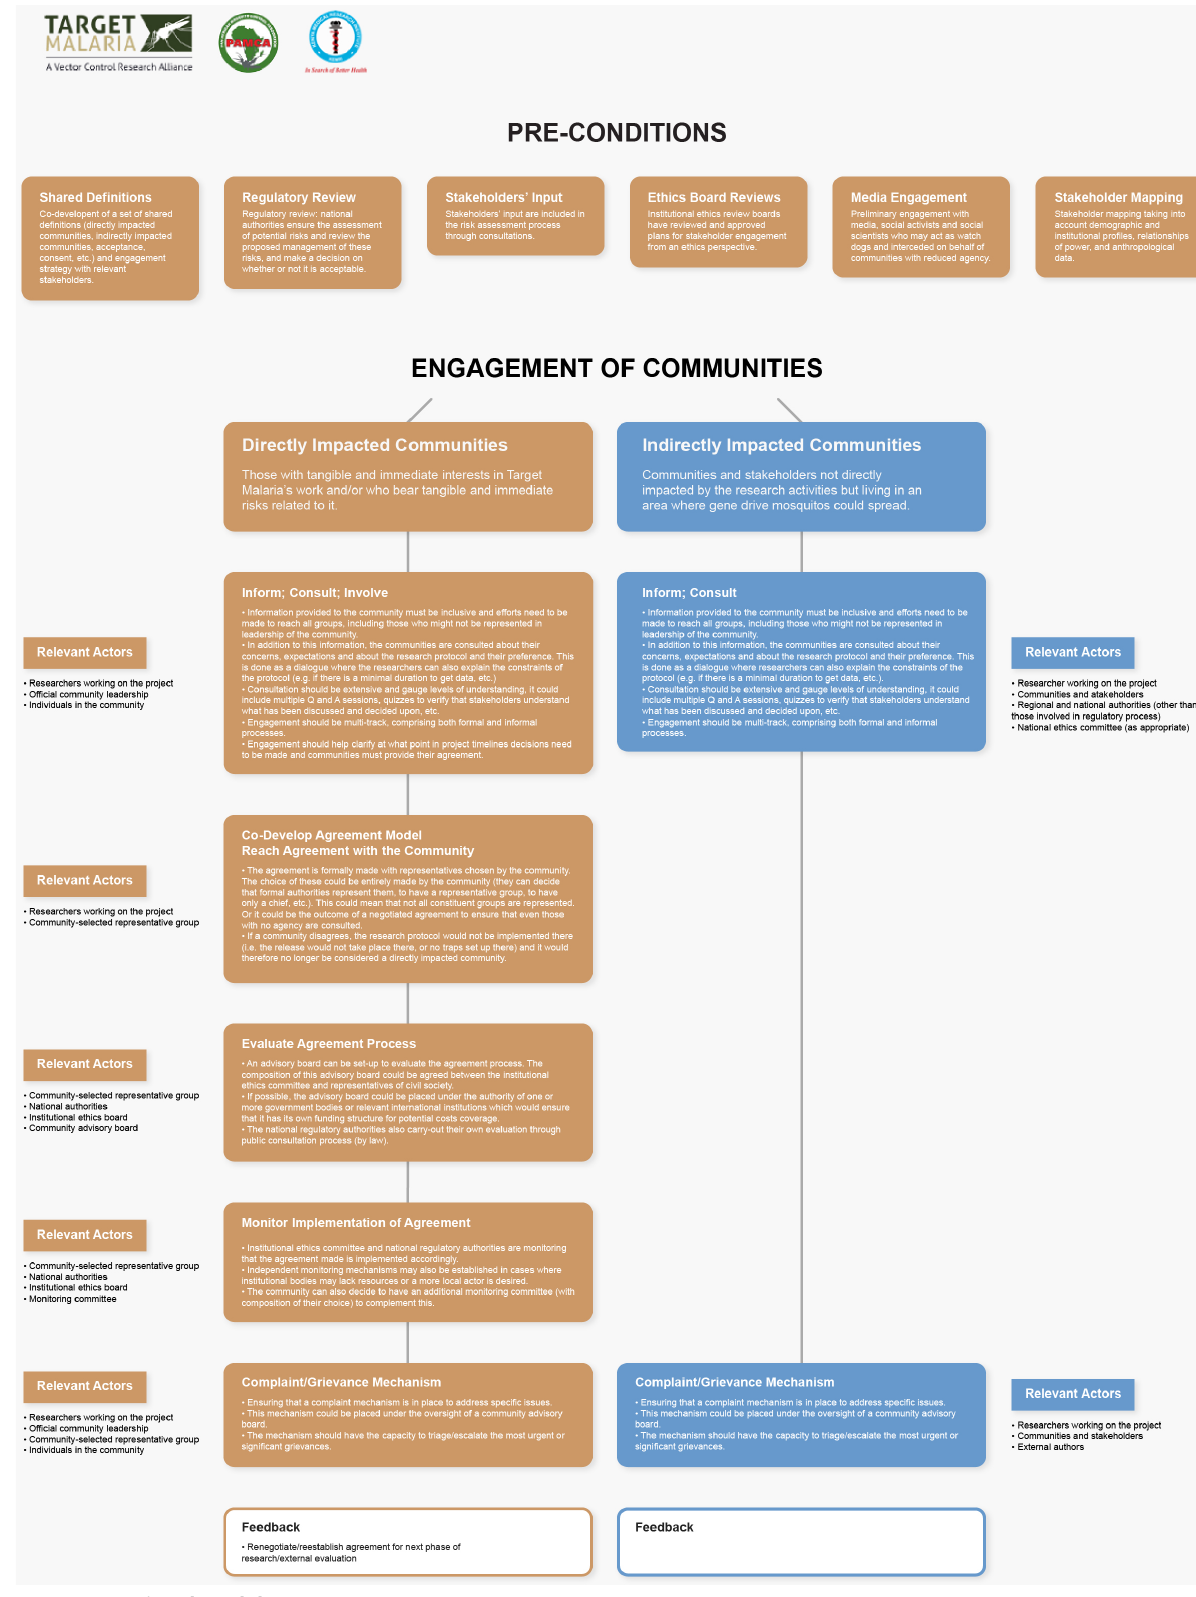
Figure 2. Operational